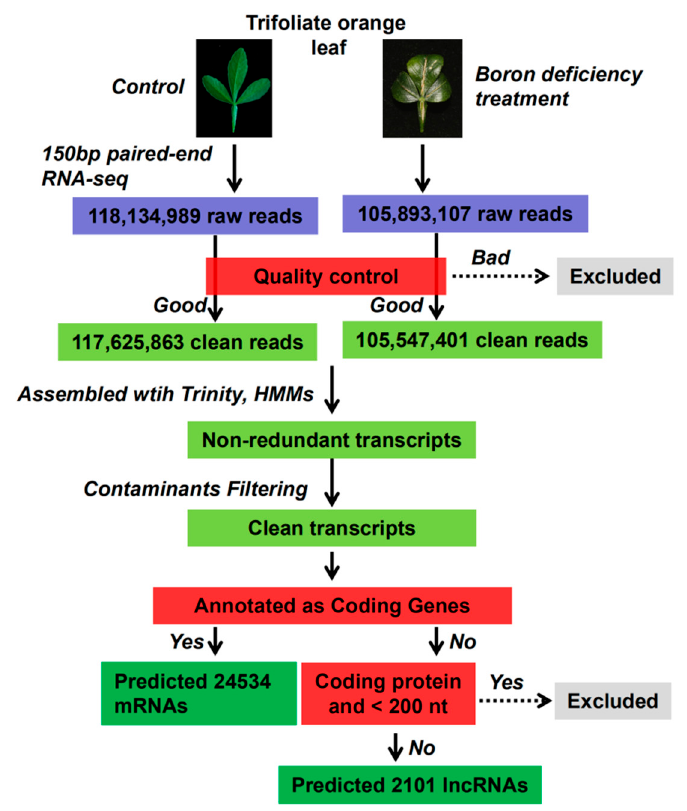
Figure 2. The general flowchart of the pipeline used to identify the repertoire of long non-coding RNAs (lncRNAs) from trifoliate orange expressed under boron deficient stress